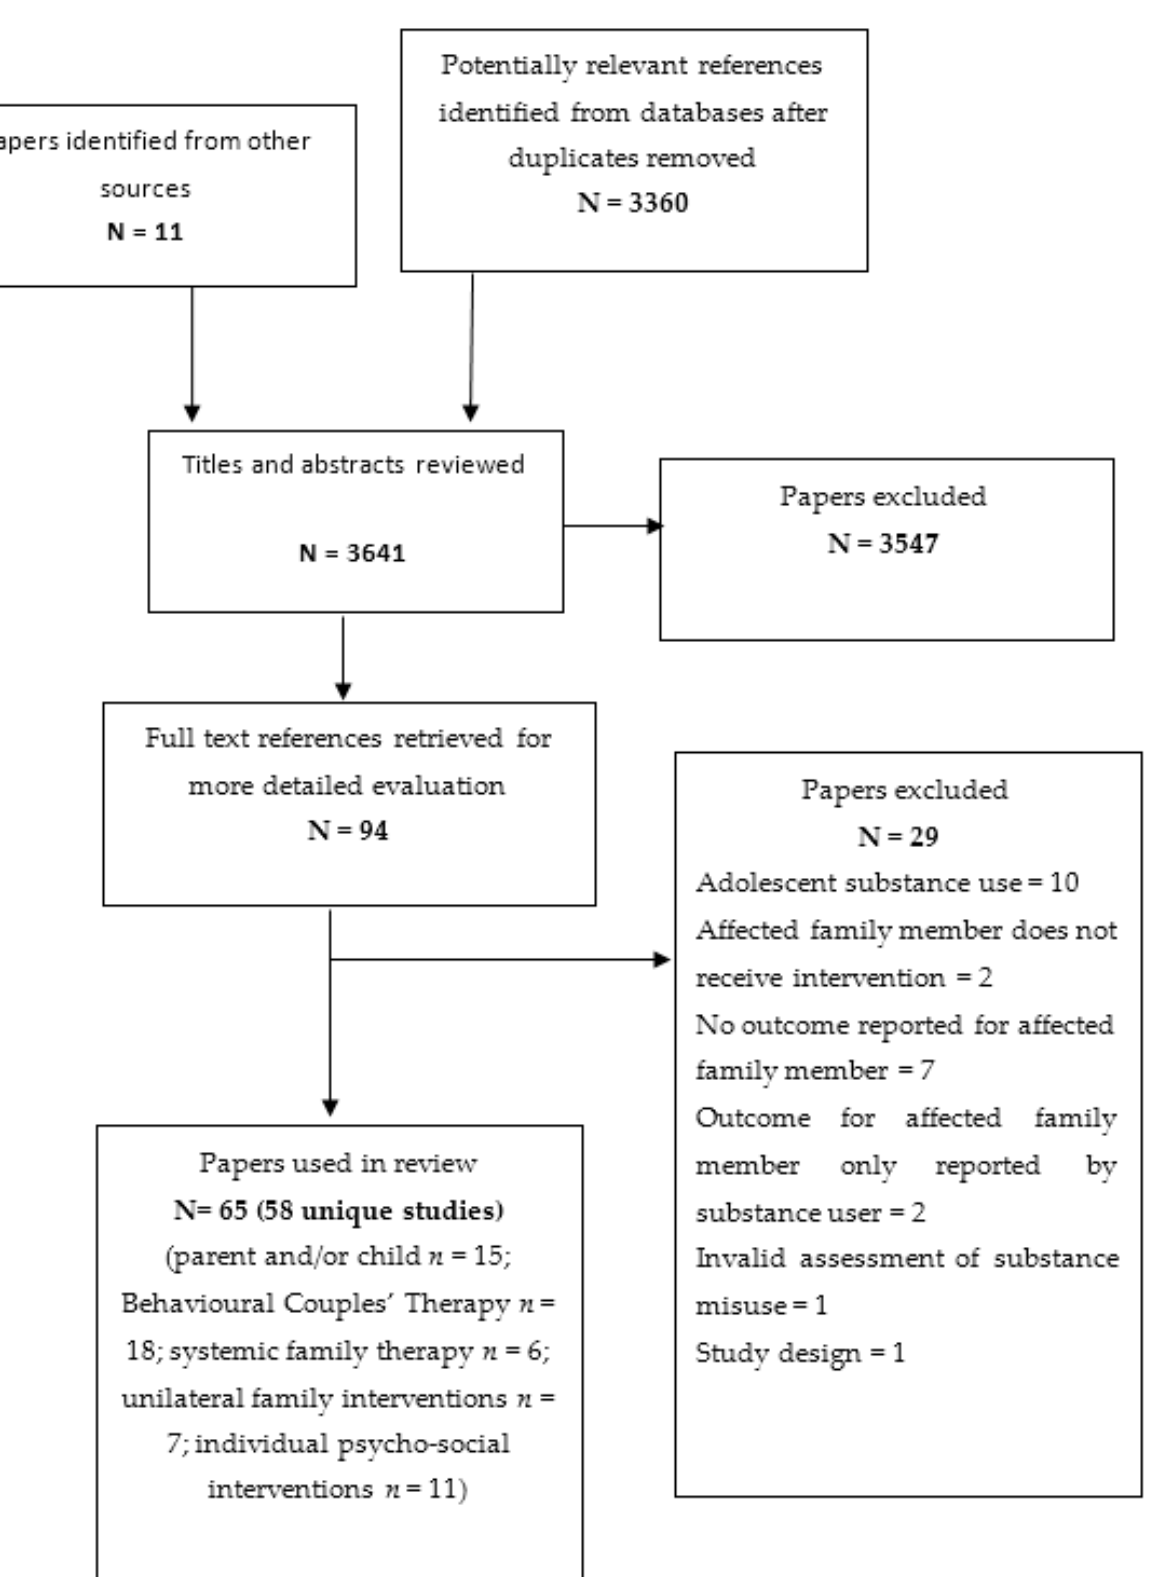
Figure 1. Flow of studies.